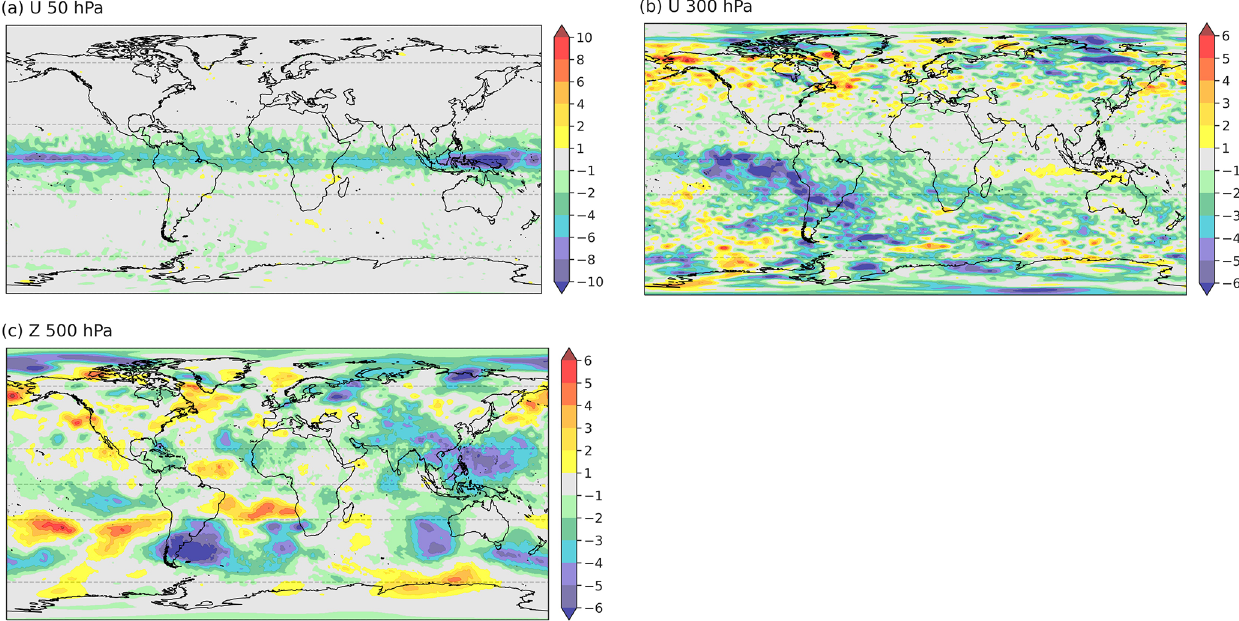
Figure 1. The mean relative differences in 24–120h forecast RMSE between the EXP_A and the CTRL run (%) for 1 July to 30 September